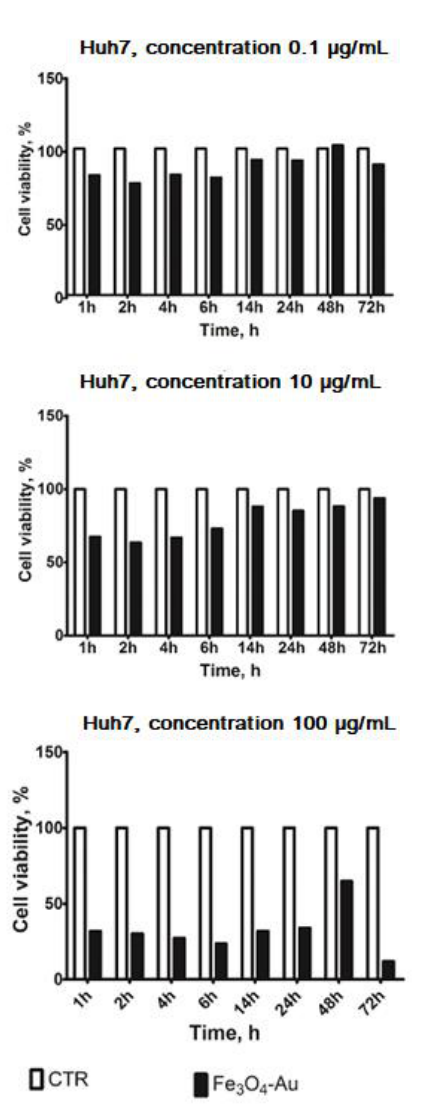
Figure 6. Huh7 cell viability after Fe 3 O 4 -Au NP incubation at increasing time steps and different